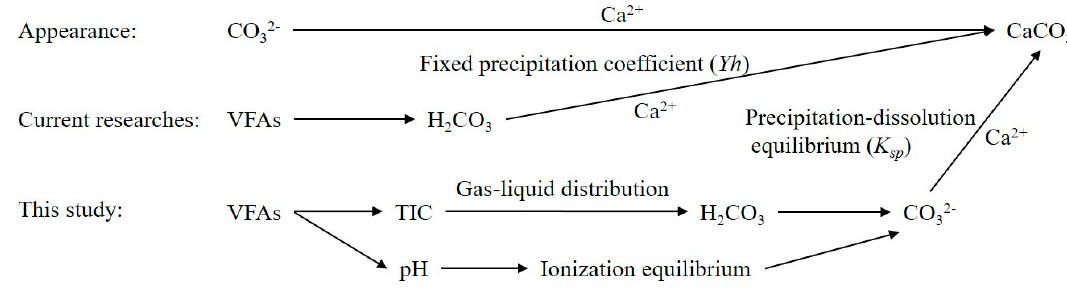
Figure 7. The calculating paths of biochemical reactions.